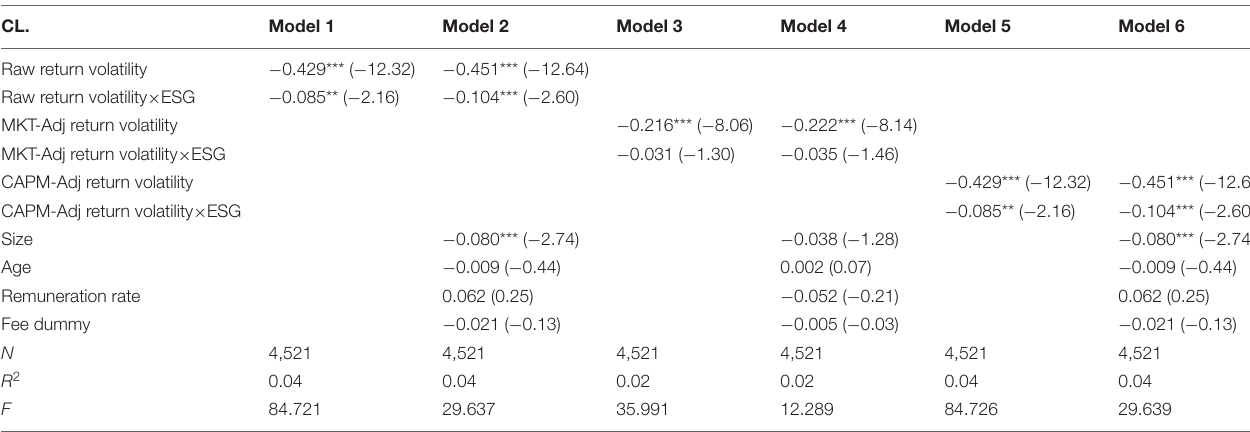
Table 6 is the result of analyzing fund flow–performance volatility sensitivity. The dependent variable is fund flow. Raw return volatility, the volatility of raw return over the previous 12 months; MKT-Adj return volatility, the volatility of the market-adjusted returns over the previous 12 months; CAPM-Adj return volatility, the volatility